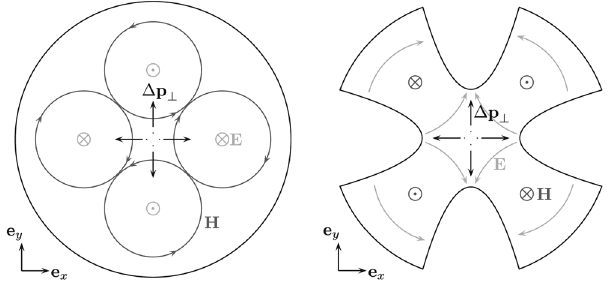
FIG. 1. Qualitative description of the quadrupolar fields leading to a transverse kick on a charged particle (cross-section). The direction of the momentum change Δ p ⊥ is indicated for a positively charged particle. Left: Elliptical cavity type operating in a TM mode. Right: Four-vane cavity operating in a TE